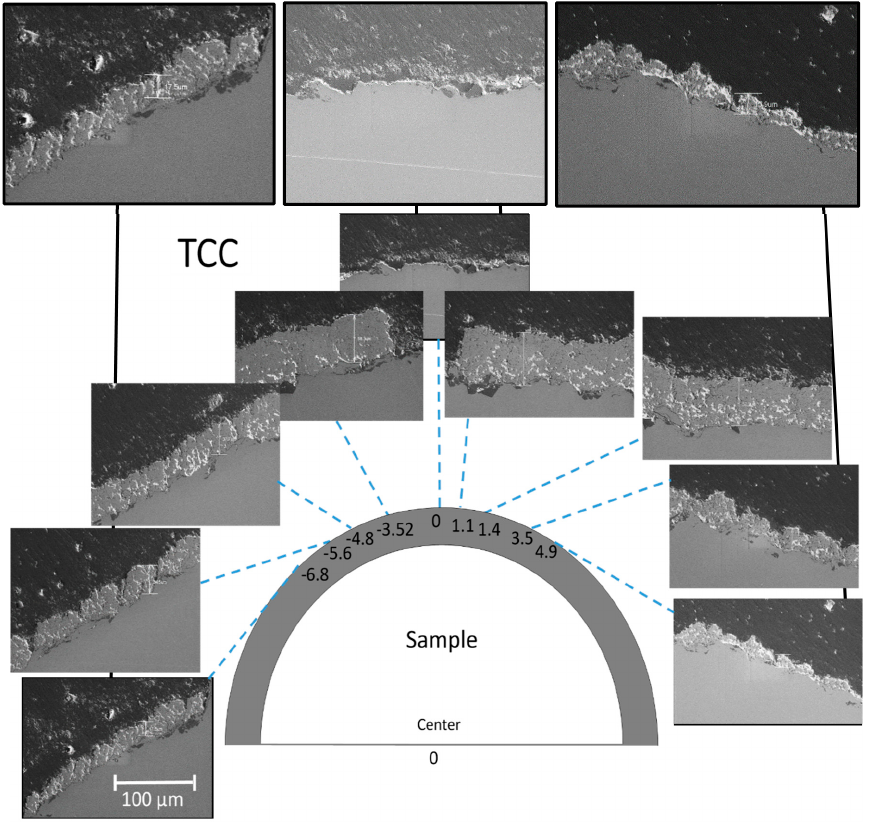
Figure 12. Metallographic SEM images of the coating cross-section deposited on the cylindrical coarse grit-blasted substrate (TCC) and recorded at different locations along the substrate surface.